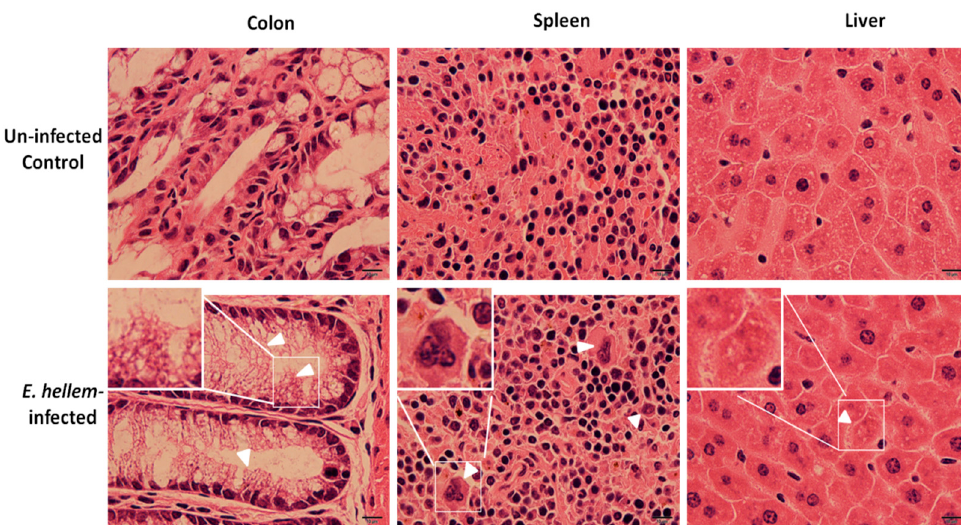
Figure 3. Histopathological analysis. Uninfected control and E. hellem -infected mice organs (colon, spleen and liver) were collected and frozen sectioned respectively. All sections were then subjected to hematoxylin and eosin staining. Here are the representative images of few E. hellem -infected organ samples with histopathological changes. In colon, enlarged microvilli were observed (white arrow heads); In spleen and liver, lymphoepithelioid granulomas were seen (white arrow heads). Images are representatives of all samples from eight control and infected mice respectively. (scale bar = 10 μ m).